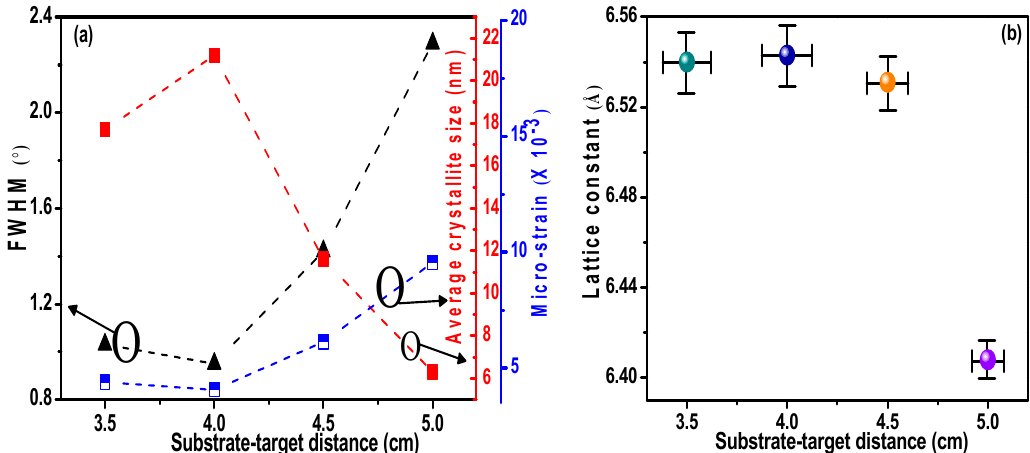
Figure 4. Crystal parameters of CdTe films prepared at various substrate-target distances. ( a ) Full width at half maximum, average crystallite size, and micro-strain; ( b ) lattice constant. Materials 2018 , 11 , x FOR PEER REVIEW Table 2. Crystal parameters of CdTe films prepared at different substrate-target distances, D ts .